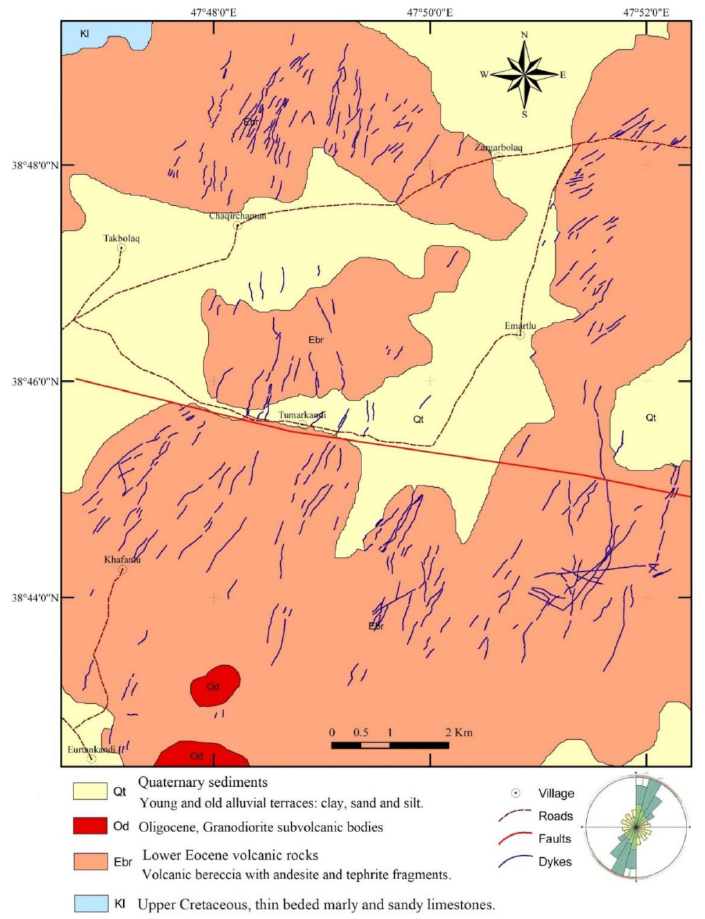
Figure 2. Geological map of the northeast of the Meshkinshahr [50] and present work on the distribution of mafic dyke swarms is